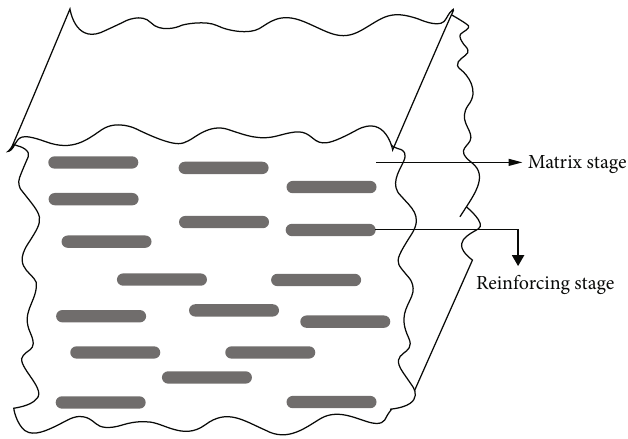
Figure 1: Nanocomposite